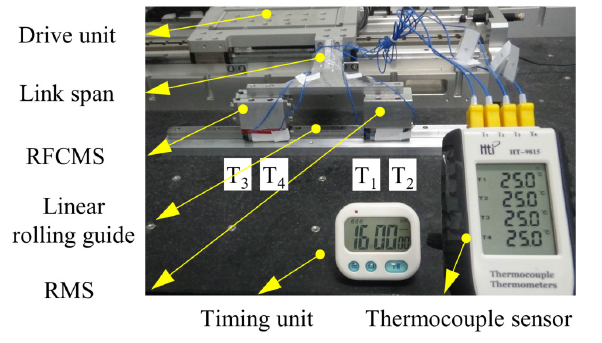
Figure 8. A schematic of the test rig.